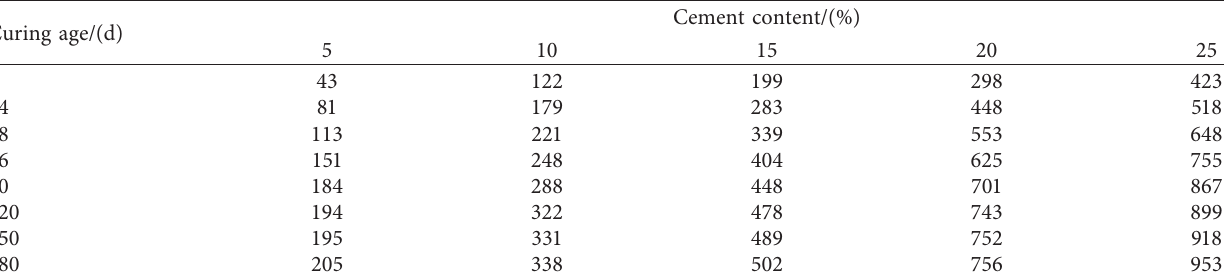
Table 3: The UCS of the